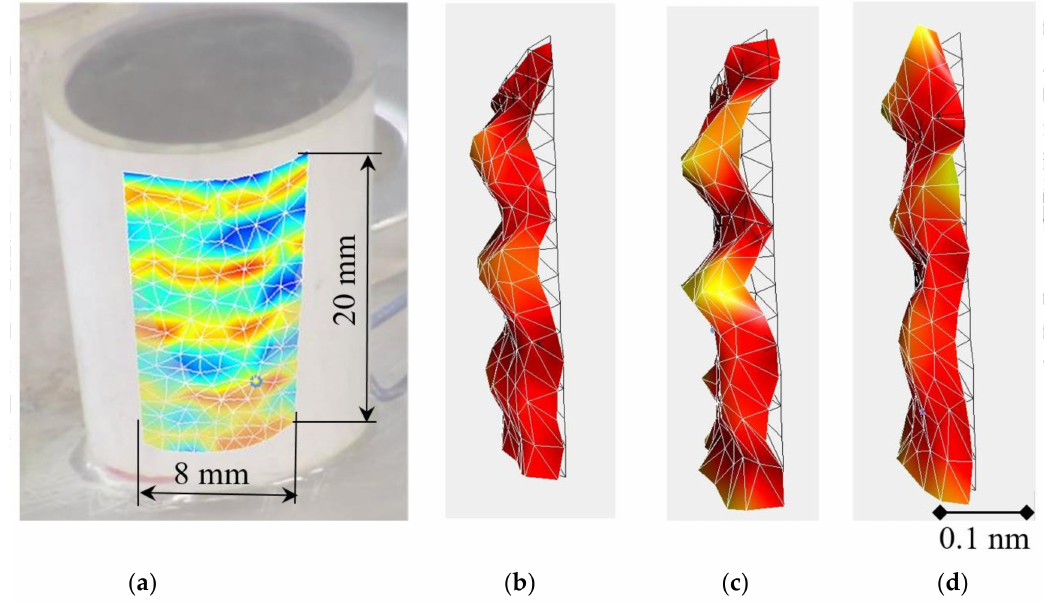
Figure 6. Photo of the tube-shaped prototype actuator and a segment of its surface ( a ), which is 3D-scanned to determine vibrating deflection shapes and eigenmodes of the actuator ( b – d